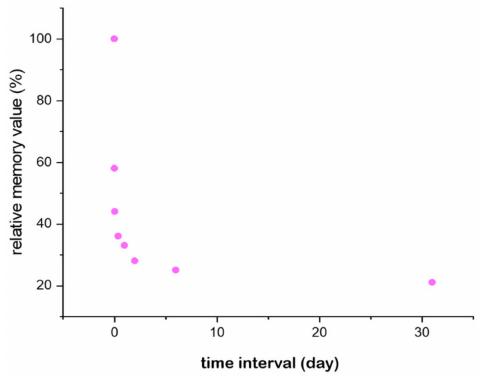
Figure 1. Memory values on the forgetting